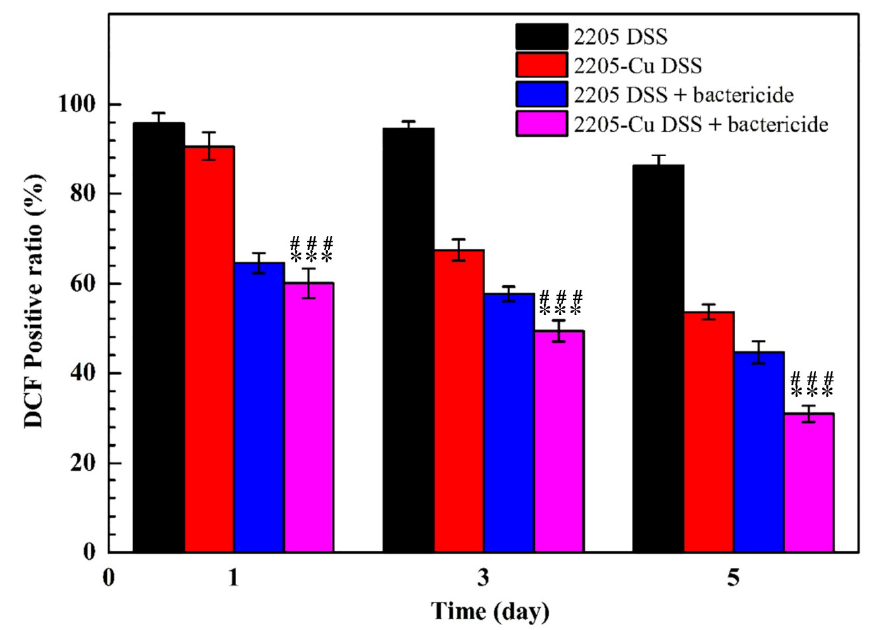
Figure 5. Adherent bacteria survival rate of different groups. *** p < 0.001 (sample vs the 2205 DSS group); ### p < 0.001 (sample vs the 2205-Cu DSS group). ( n = 3). group); ### p < 0.001 (sample vs. the 2205-Cu DSS group). ( n =